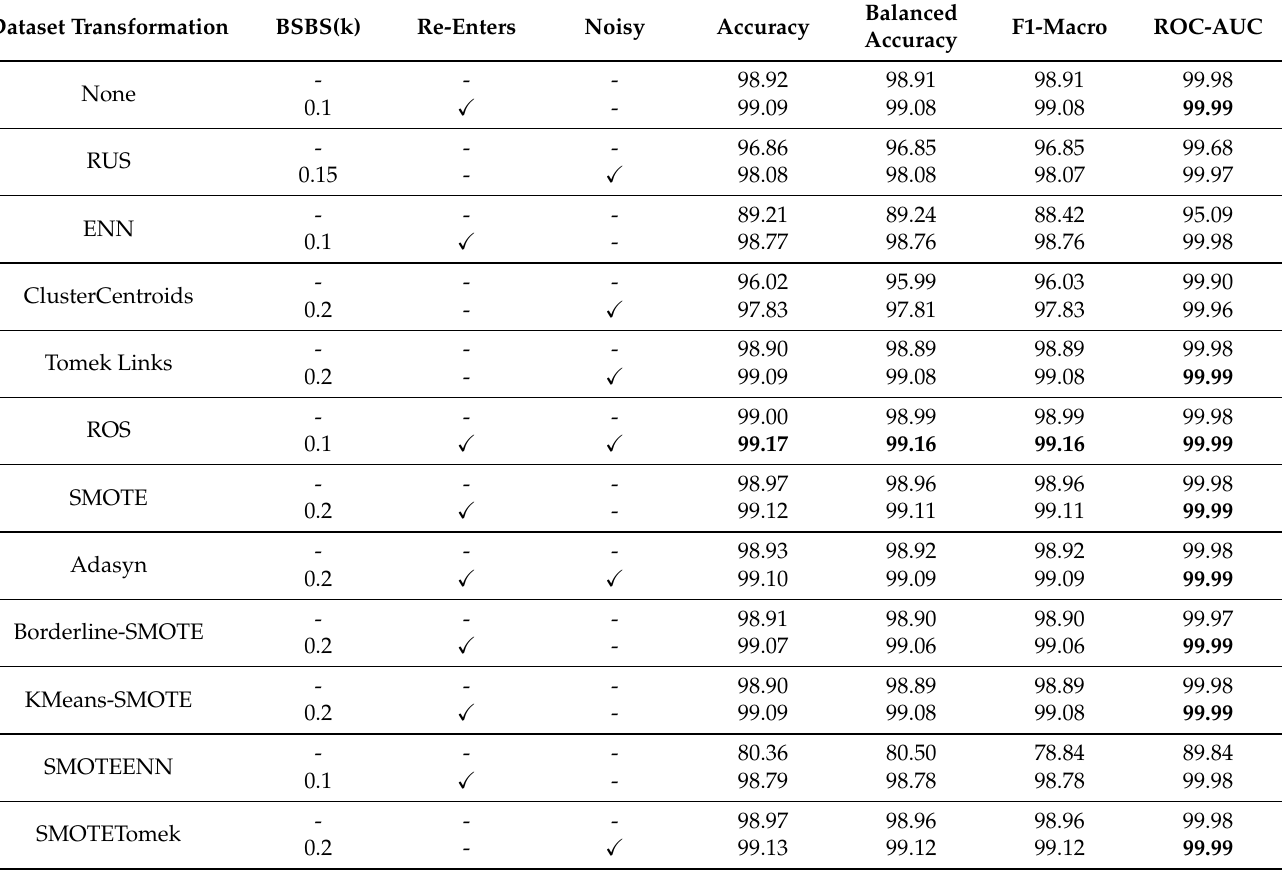
Table 8. Results for the MNIST